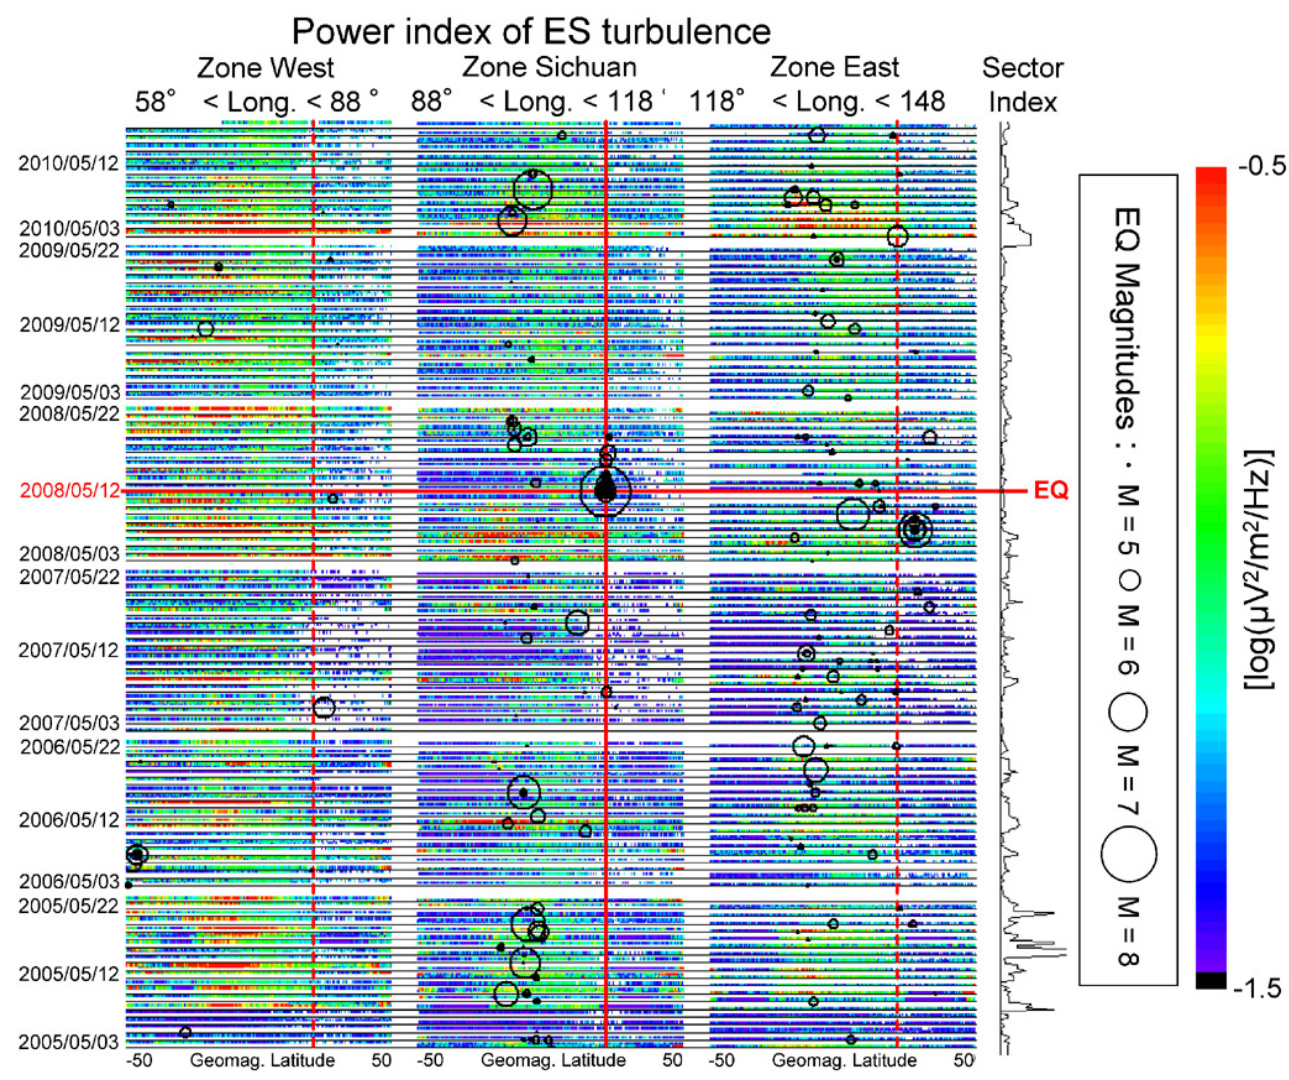
Fig. 7. All original data of power index of electrostatic turbulence used in this statistical study from year 2005 to year 2010. The data are sorted along three zones, the Sichuan zone (central column) and the two reference zones west (left) and east (right) to the Sichuan zone. In each column, geomagnetic latitudes are on the x-axis, positive in the Northern Hemisphere, negative in the Southern Hemisphere. For each year the time in days varies along the y-axis between 3 and 22 May. The time and geomagnetic latitude of the Sichuan EQ are indicated by horizontal and vertical red lines. The EQ geomagnetic latitude is indicated by a dotted red line in the reference zones. All earthquakes with M ≥ 5 that occurred in these zones and periods are marked with circles, whose diameter is proportional to the